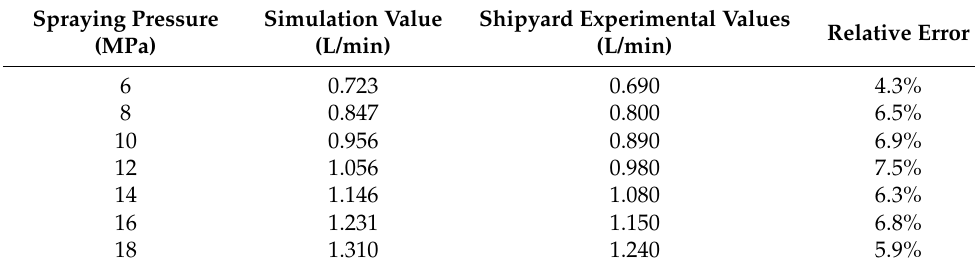
Table 4. Error comparison between simulation and